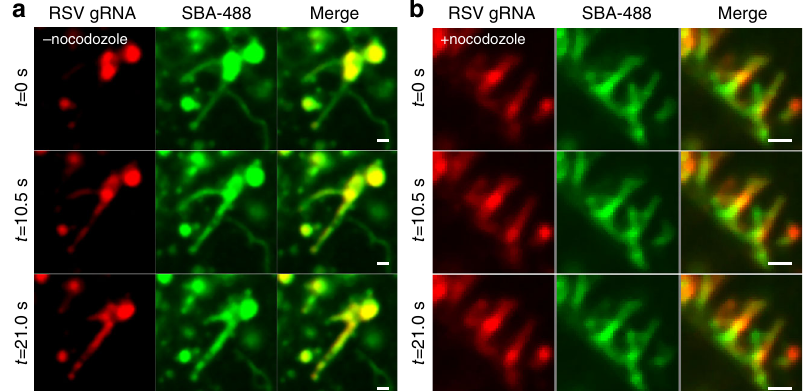
Fig. 9 RSV genomic RNA is assembled with extended fi laments. a Vero cells were infected with RSV at an MOI of 1. At 12 hpi, Cy3B-labeled MTRIPs ( red ) targeted to RSV genomic RNA were delivered at 30 nM. After membrane recovery, SBA-488 ( green ) was delivered and allowed to internalize for 1 h. Cells were then imaged live at 4.3 Hz. Images were smoothed with a fi ne rolling ball fi lter in Volocity. Scale bar represents 1 µ m. b Vero cells were infected with RSV at an MOI of 1. At 12 hpi, Cy3B-labeled MTRIPs ( red ) targeted to RSV genomic RNA were delivered at 30 nM. After membrane recovery, SBA-488 ( green ) was delivered and allowed to internalize for 1 h. Microtubules were then disrupted using nocodazole. Cells were then imaged live at 4.2 Hz. Scale bar represents 1 µ